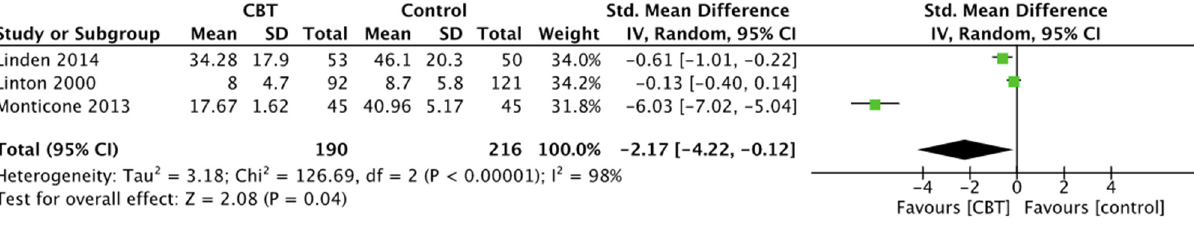
Figure 13. Fear-Avoidance beliefs: CBT versus control.